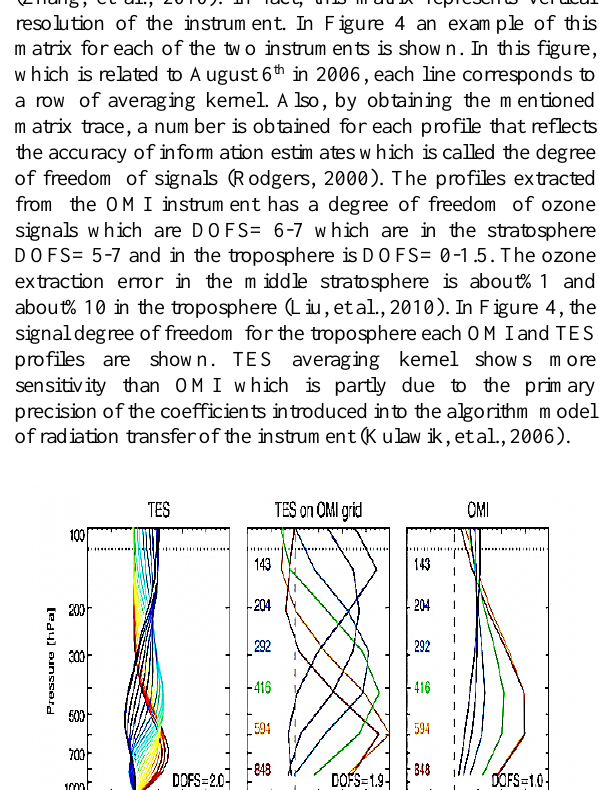
4- Validation of Satellite Tropospheric Ozone